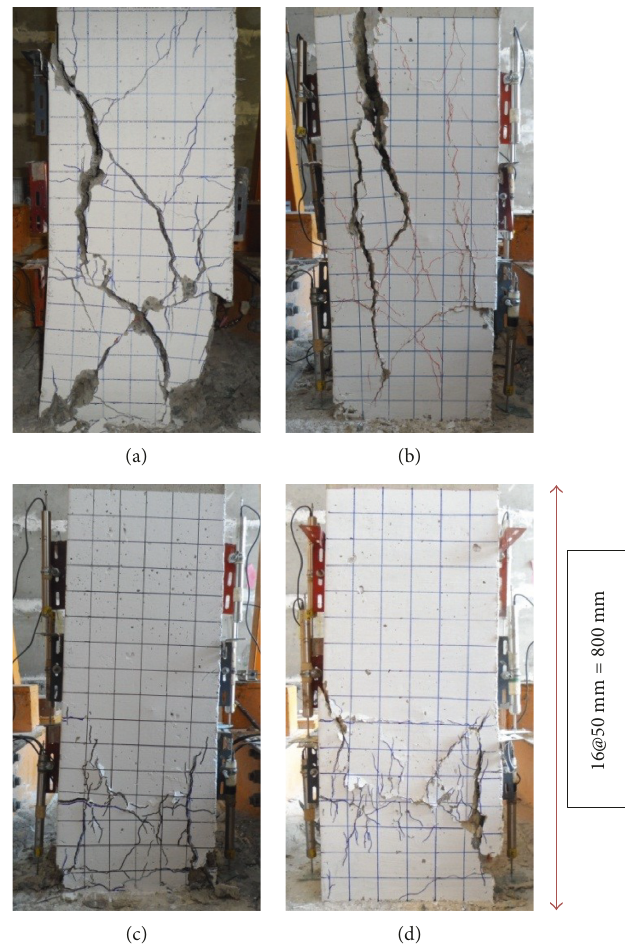
Figure 6: Failure pattern of column specimens. (a) 12L-0.2 (3.5% drift); (b) 12L-0.6 (1.75% drift); (c) 9L-0.2 (4.0% drift); (d) 9L-0.6 (1.75%